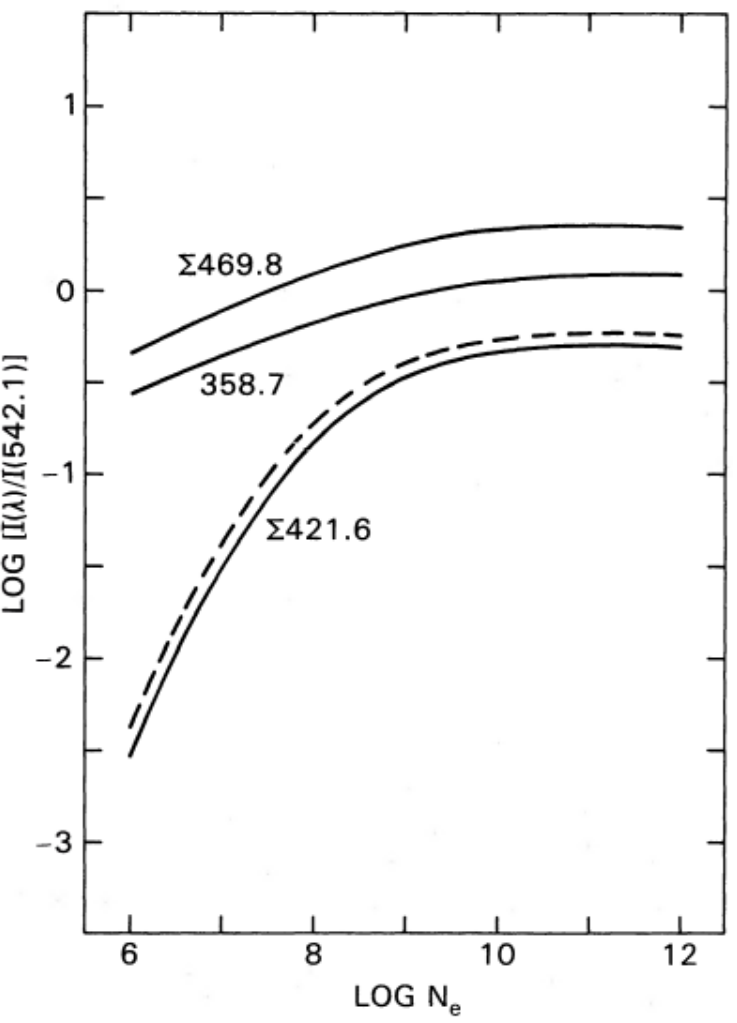
Figure 2. Density sensitive multiplets of N